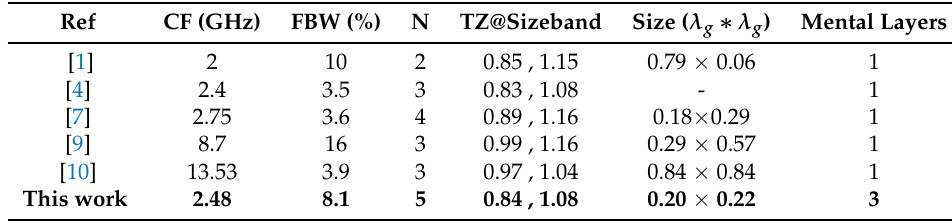
Figure 6. Simulated and measured results of the proposed BPF (solid lines: measured results; dash lines: simulated results) ( a ) Simulated and measured amplitude of S parameters (dB). ( b ) Measured group delay (ns). ( c ) Simulated and measured phase of S parameters (deg). Table 1. Performance Comparisons with previous